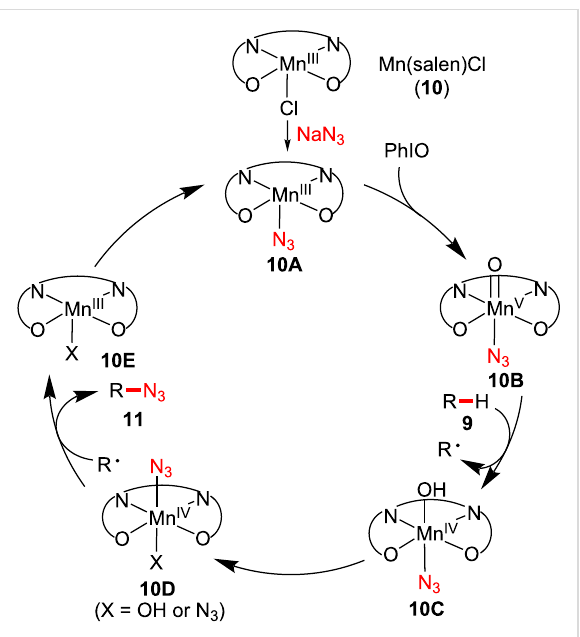
Figure 3: Proposed reaction mechanism of manganese-catalyzed C–H azidation.